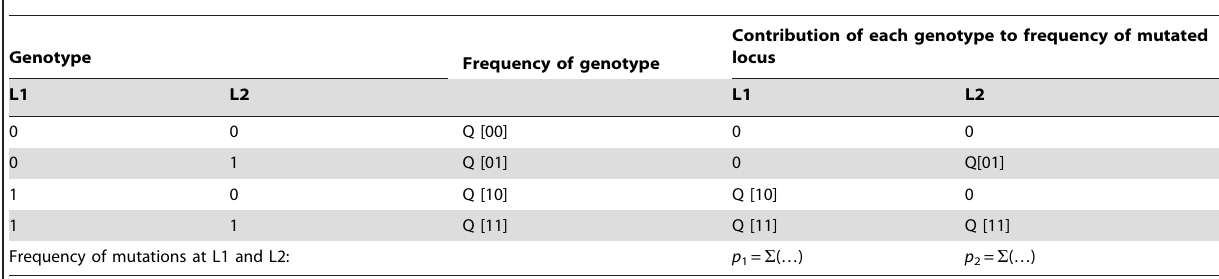
Table 1. Converting a distribution of genotypes into a distribution of mutations: Example for 2-locus case.